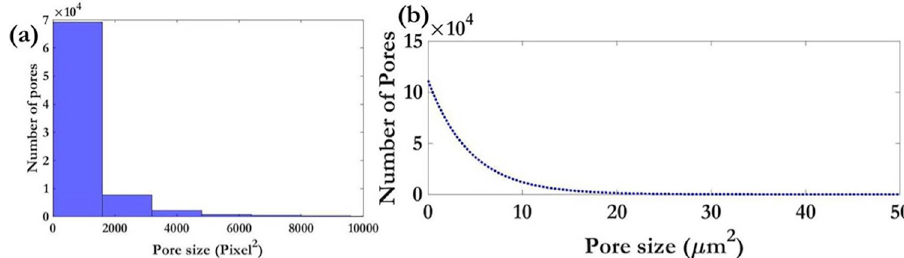
Fig 2. Analysis of pore network via μ -CT scans : (a) Histogram of pore sizes in an untreated specimen (b): Probability distribution function of pore sizes in an untreated specimen.